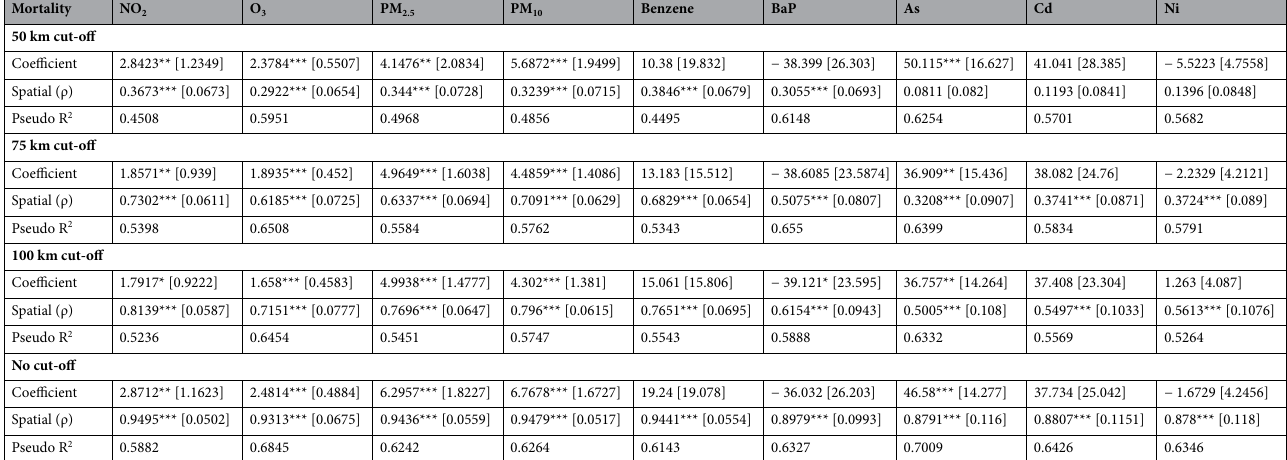
Table 16. Results from SAR models on COVID-19 excess mortality registered on 28 February 2021. p-value < 0.01***; p-value < 0.05**; p-value < 0.1*. Standard errors in parentheses. All models included a constant and the following controls: dummies for regional capitals and national borders, size of the province, population aged 0–19, distance from nearest airport, share of foreigners, share of male population, population density, degree of urbanization, deaths due to LRT disease, smokers, obese individuals, large firms, altitude, and rainy